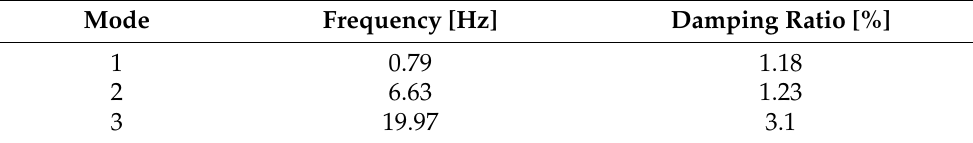
Figure 4. Experimental Frequency Response Functions (FRF) of the cantilever beam for the first three mode-shapes. Table 3. Modal parameters of the cantilever beam obtained with Peak Picking techniques.